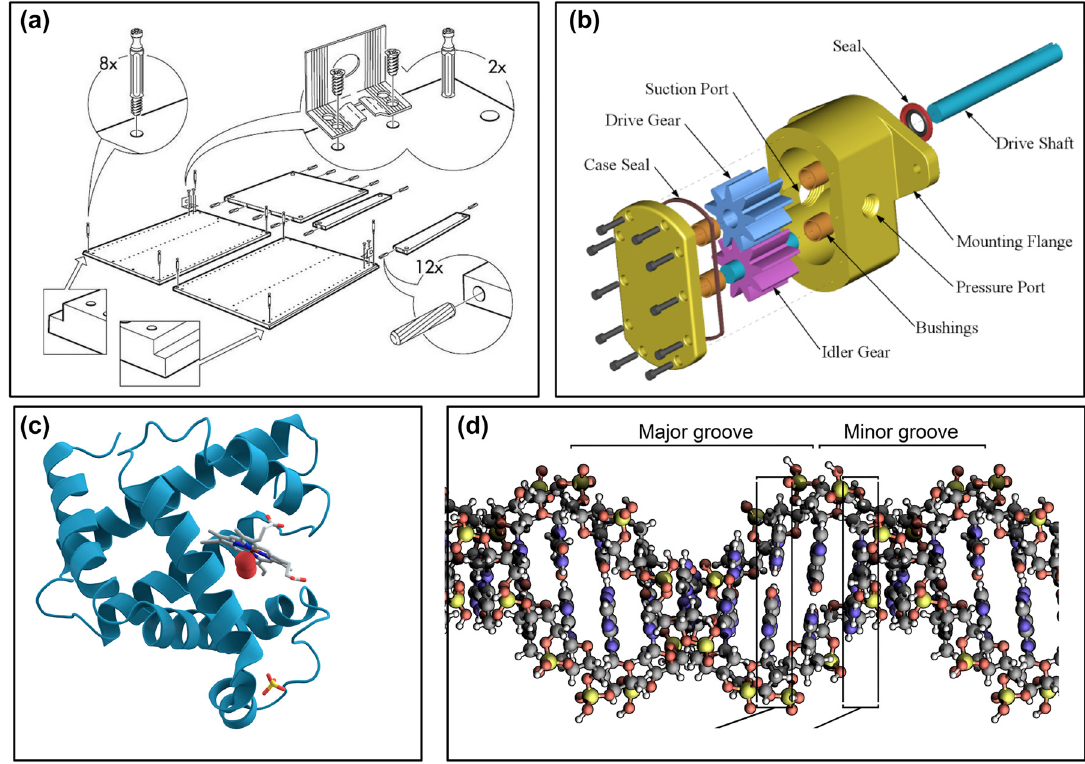
Figure 1: Representation of structural features can be assimilated to technical drawings. (a) Instructions for mounting furniture; (b) drawing of a gear pump [19]; (c) structure of Myoglobin [20] and (d) of DNA